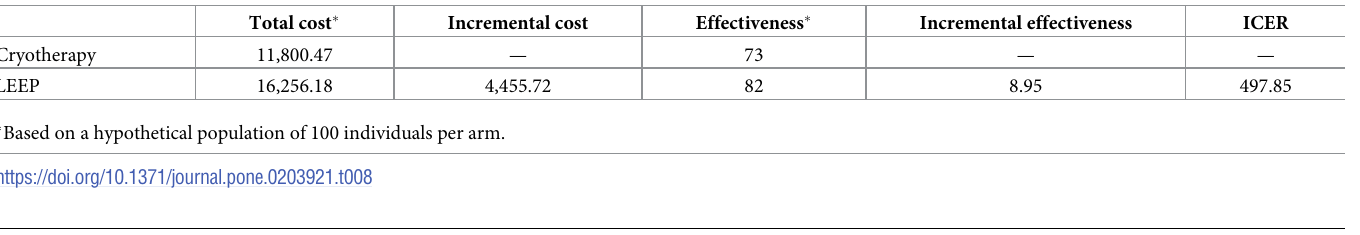
Table 8. Cost-effectiveness (US$ 2015), as-treated